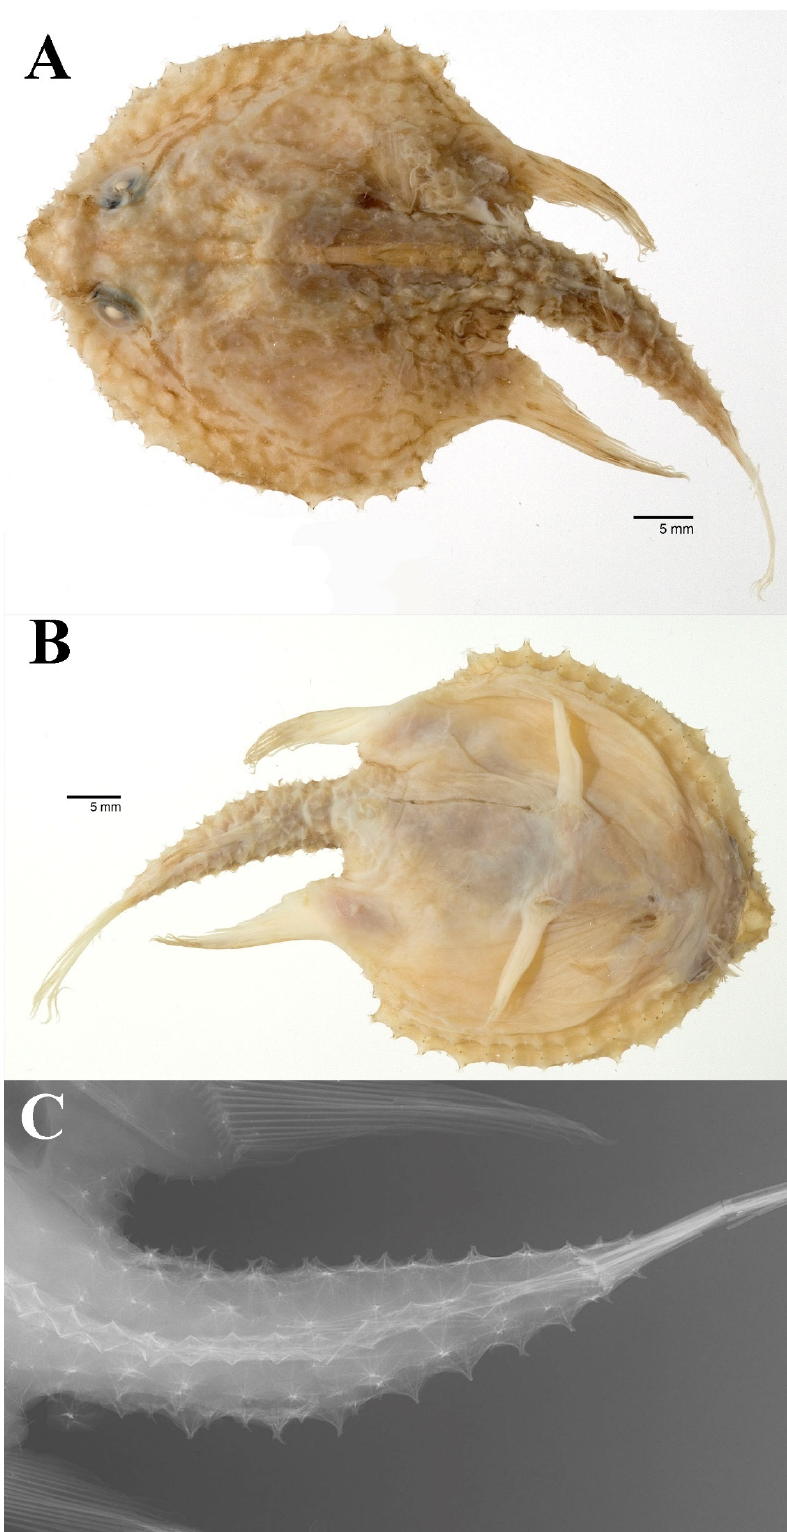
Figure 20. Halieutopsis nasuta (Alcock, 1891), holotype of junior synonym H. vermicularis Smith & Radcliffe, 1912, USNM 70272, 60.9 mm SL. ( A ). Dorsal view. ( B ). Ventral view. ( C ). Radiograph showing tail tubercles. Photos by S. Raredon, courtesy of